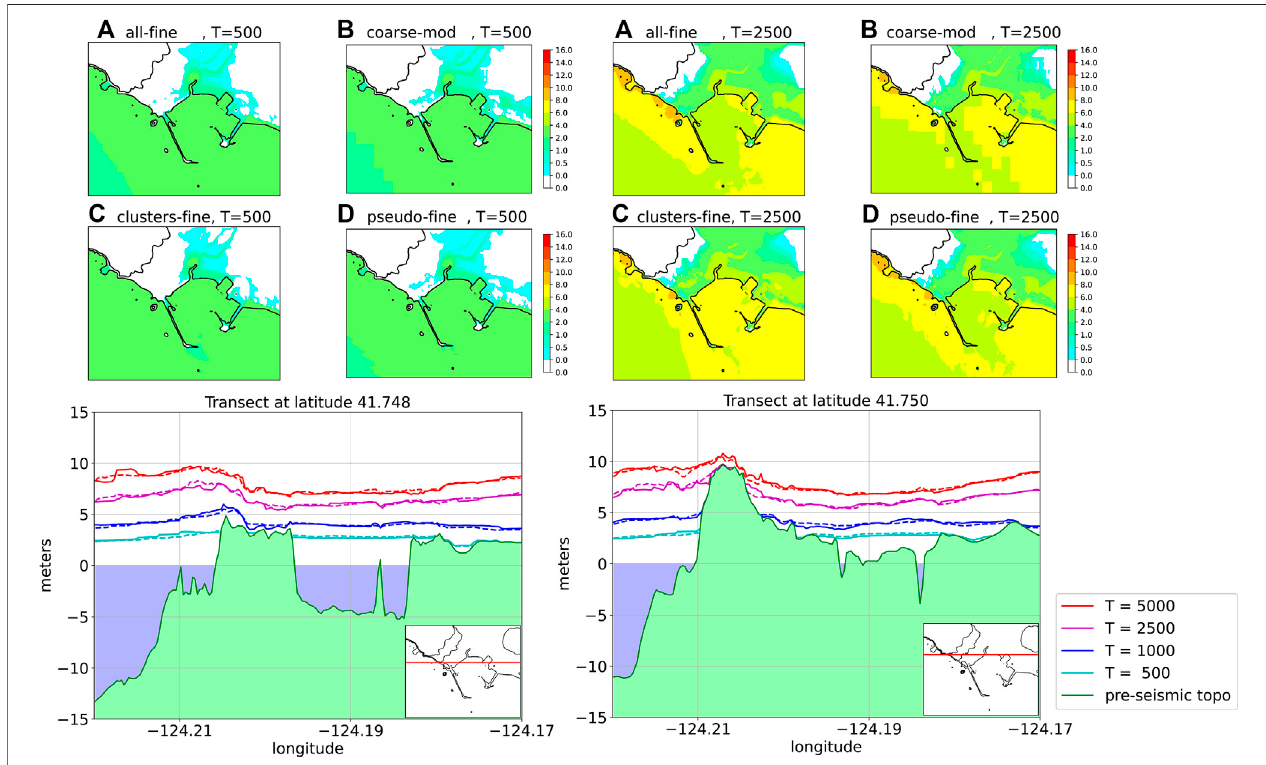
FIGURE 12 | Sample hazard maps and transects for Crescent City. As described in the caption to Figure 11 .